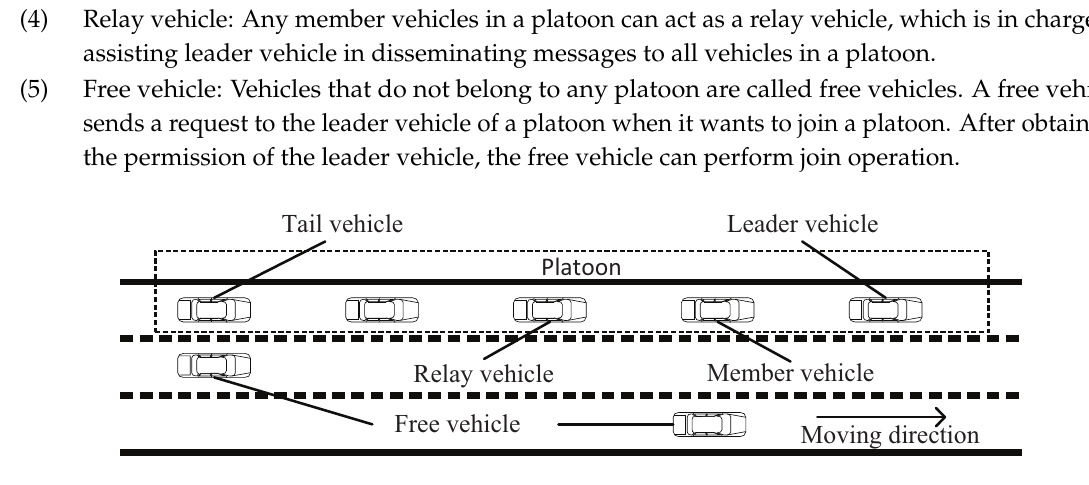
Figure 1. Platoon structure